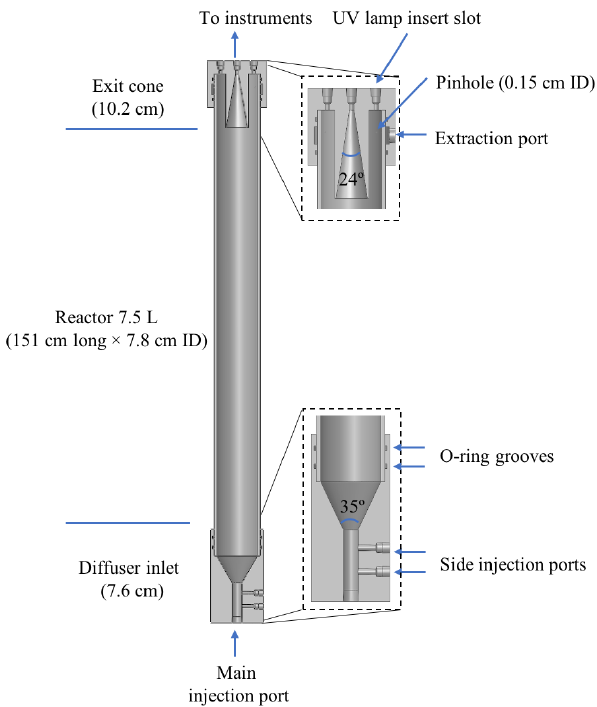
Figure 1. Cutaway view of the PFA OFR.